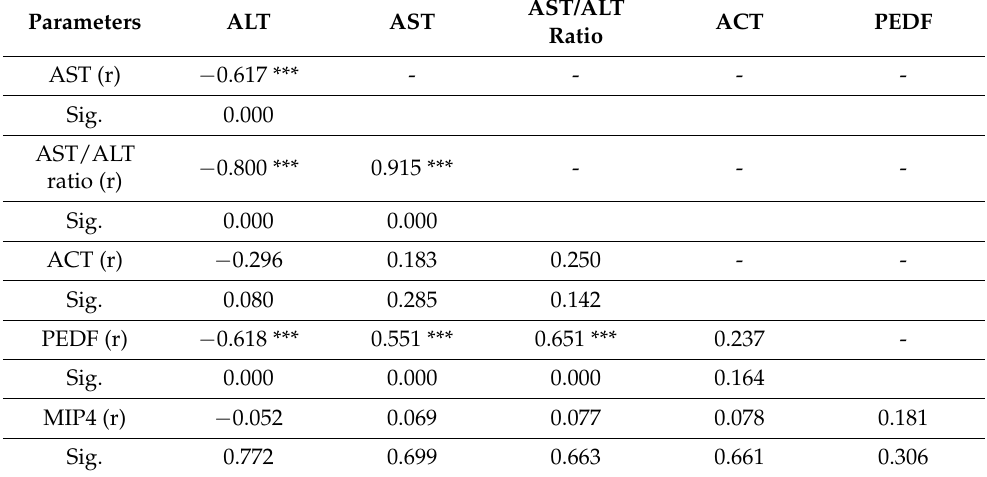
Table 3. Correlations between the biomarkers and proinflammatory cytokines and liver transaminases (ALT and AST) among all study groups.